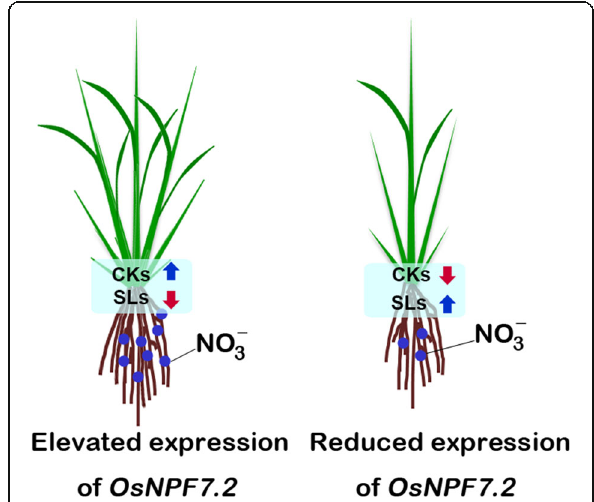
Fig. 7 The proposed model of OsNPF7.2 regulating rice tillering. Blue circles suggested nitrate, and the different number of circles indicated the different nitrate concentration between overexpression lines and repression lines. CKs and SLs were abbreviations of cytokinins and